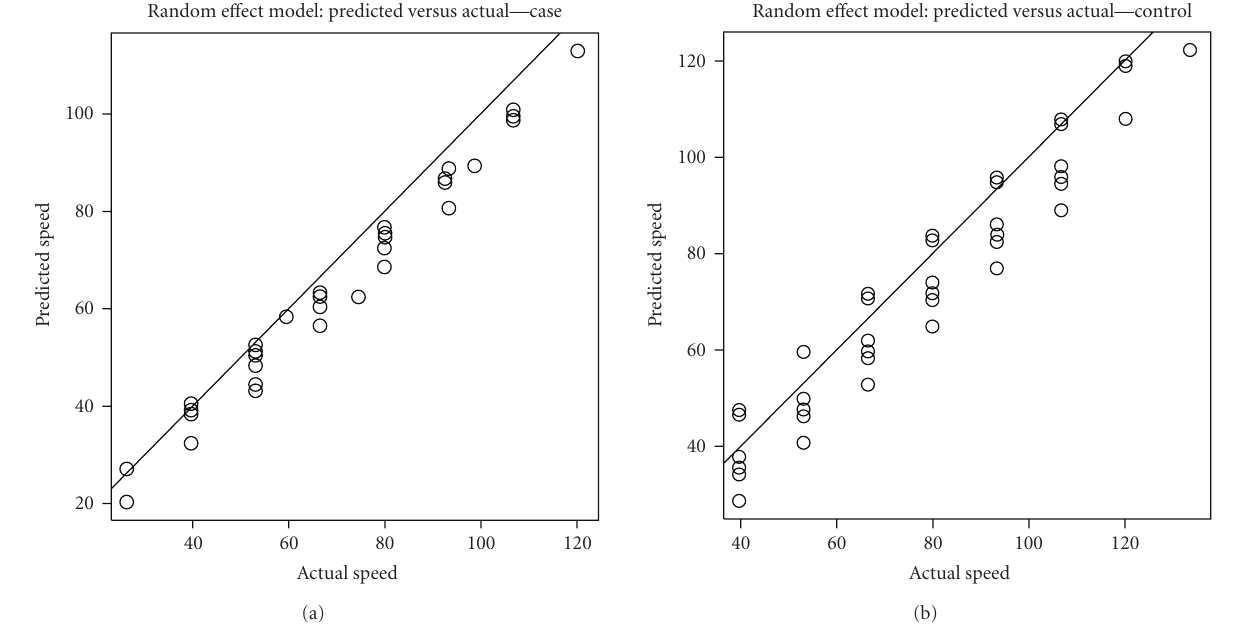
Figure 2: Mixed e ff ect models for predicted speed by the IDEEA monitor are shown in cases (a) and in controls (b). The graphs show how the IDEEA monitor readings of speed during walking predict the actual speed measured by a treadmill (meters/min). The 45 degree line on the figure is where all the predicted dots should be in a perfect world. The IDEEA monitor does as well as the treadmill in measuring walking speed with greater than 95% correlation. Although we observe a tendency for the IDEEA monitor to underestimate speed in morbidly obese cases, this di ff erence is not statistically